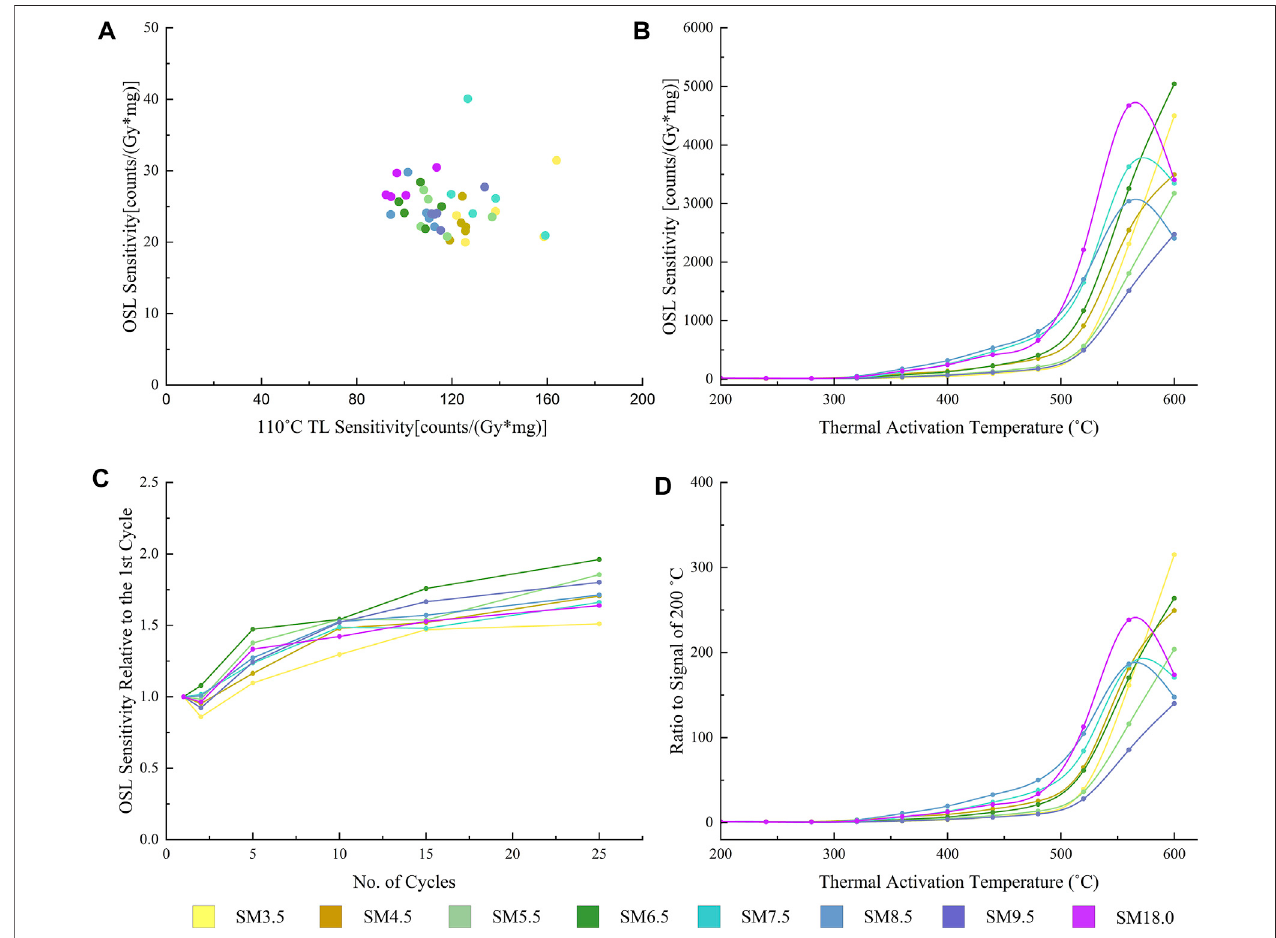
FIGURE 3 | Quartz luminescence sensitivity (QLS), thermal activation curve (TAC) and irradiation-bleaching cycles (IBCs) result in Sanming borehole. (A) QLS values of OSL sensitivity and 110 ° C TL sensitivity. (B) The absolute value of OSL sensitivity at different thermal activation temperatures. (C) The relative values of OSL sensitivity in IBC (normalized by the absolute value of the respective 1st cycle). (D) The relative value of OSL sensitivity at different thermal activation temperatures (normalized by the absolute value of 200 ° C).